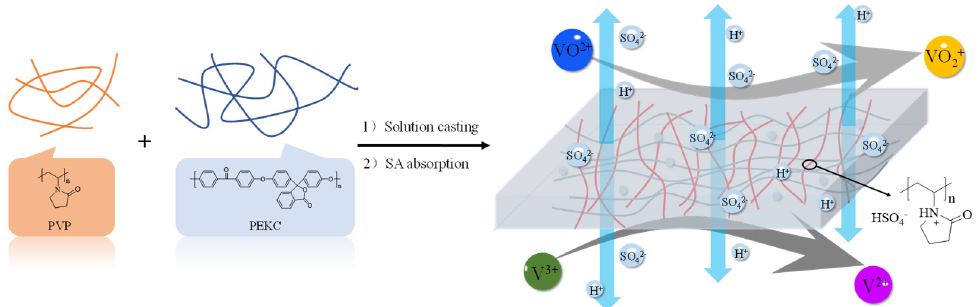
Figure 1. The schematic of fabricating x%PVP-PEKC blend membranes